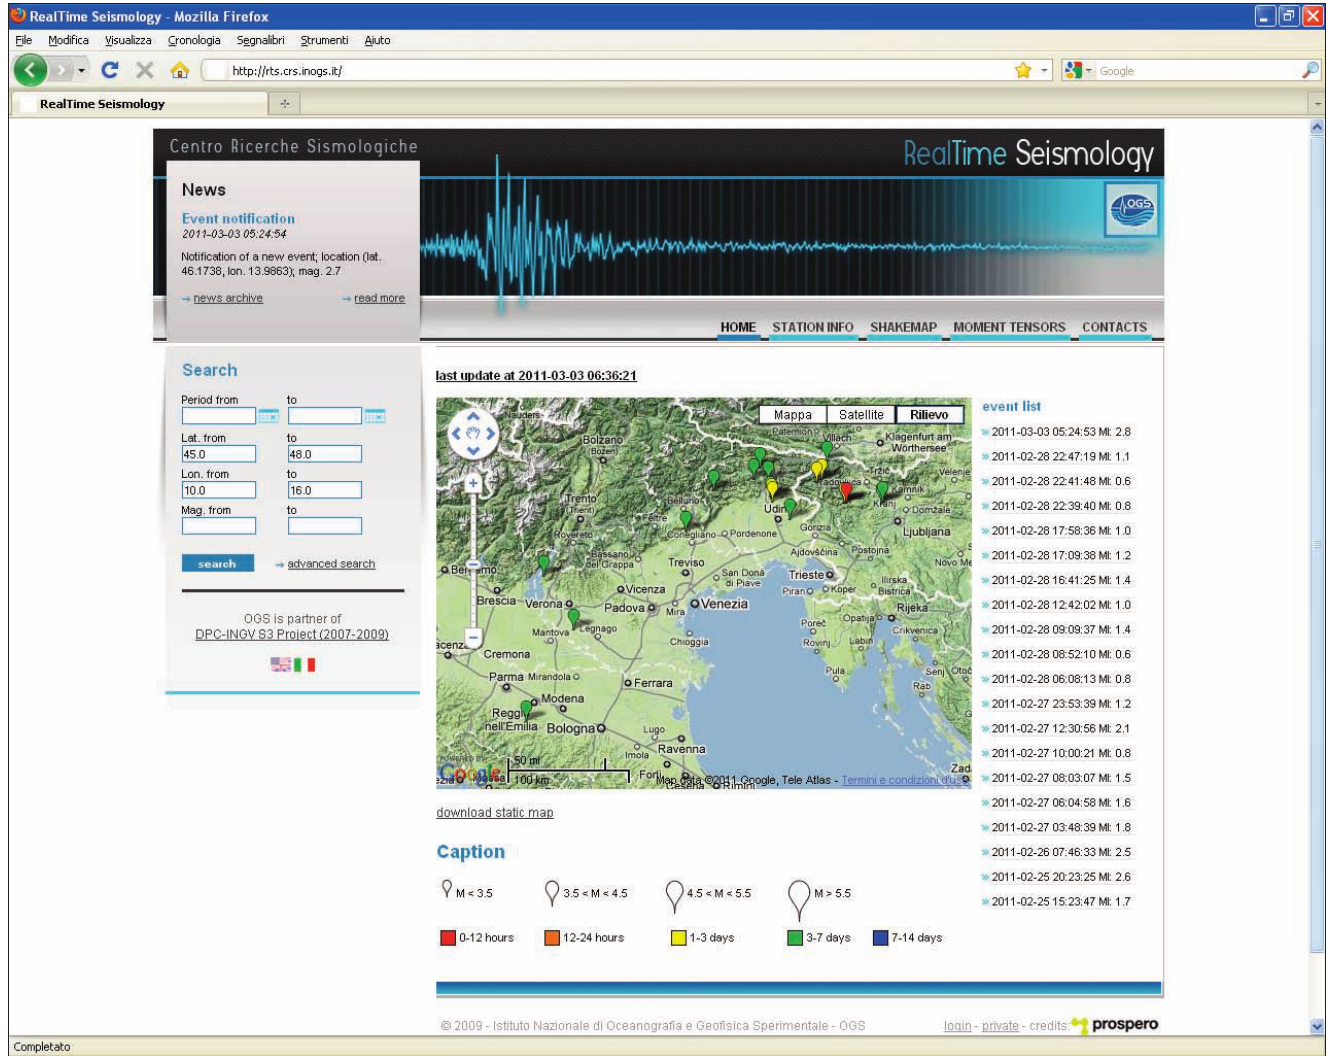
Figure 6. RTS website homepage (http://rts.crs.inogs.it/). The website publishes the map of the seismicity recorded in north-eastern Italy and surroundings, and the shake maps and the moment tensors computed in real time. It also gives information about the OGS-CRS seismic